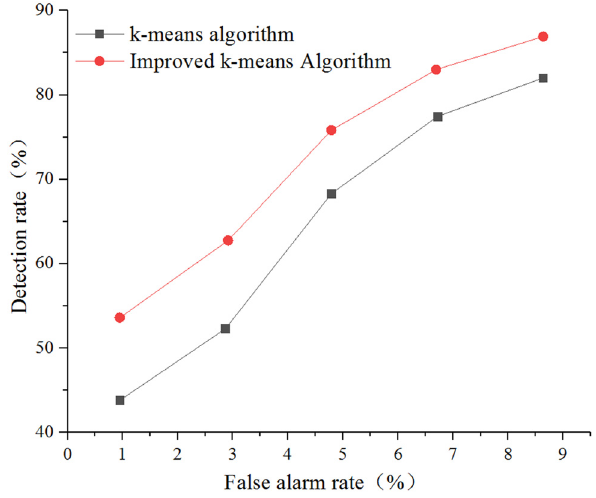
Figure 5: False alarm rate of the two algorithms.